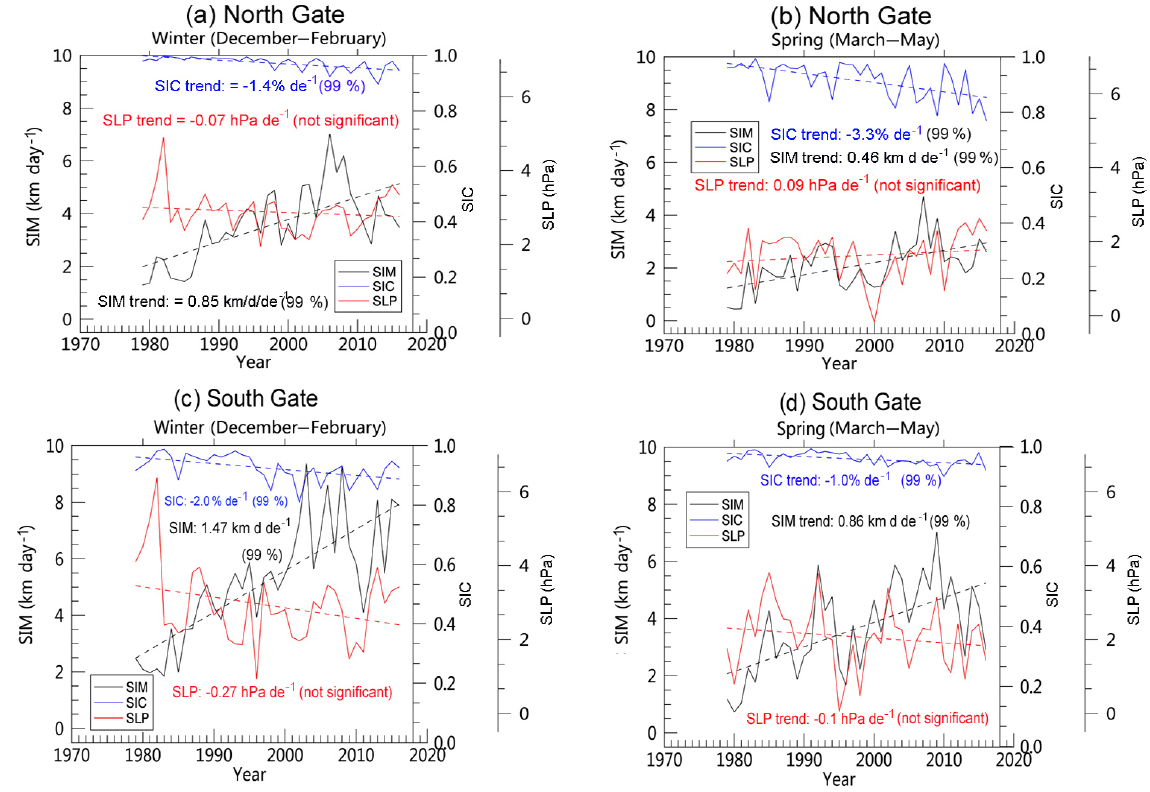
Figure 15. Trends and variability of cross-gate mean sea ice motion (thick black line) and concentration (thick blue line) for the (a, b) northern gate and (c, d) southern gate. The linear fit line for each parameter is shown as a dashed line. Cross-gate sea level pressure (SLP) difference (red) is shown to facilitate the analysis of causes of the significant trends in sea ice motion.